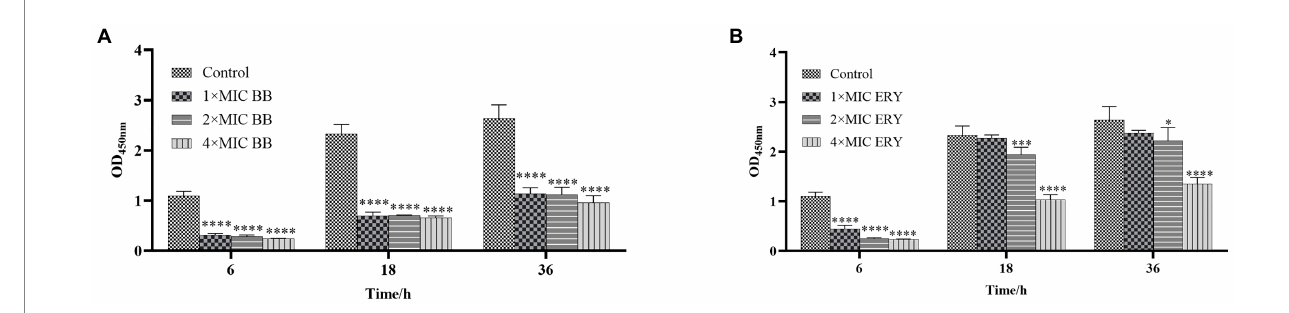
FIGURE 4 The metabolic activity at each stage of biofilm formation of SEP-05. (A) SEP-05 treated with Disaspidin BB; (B) SEP-05 treated with erythromycin. * means p < 0.05,